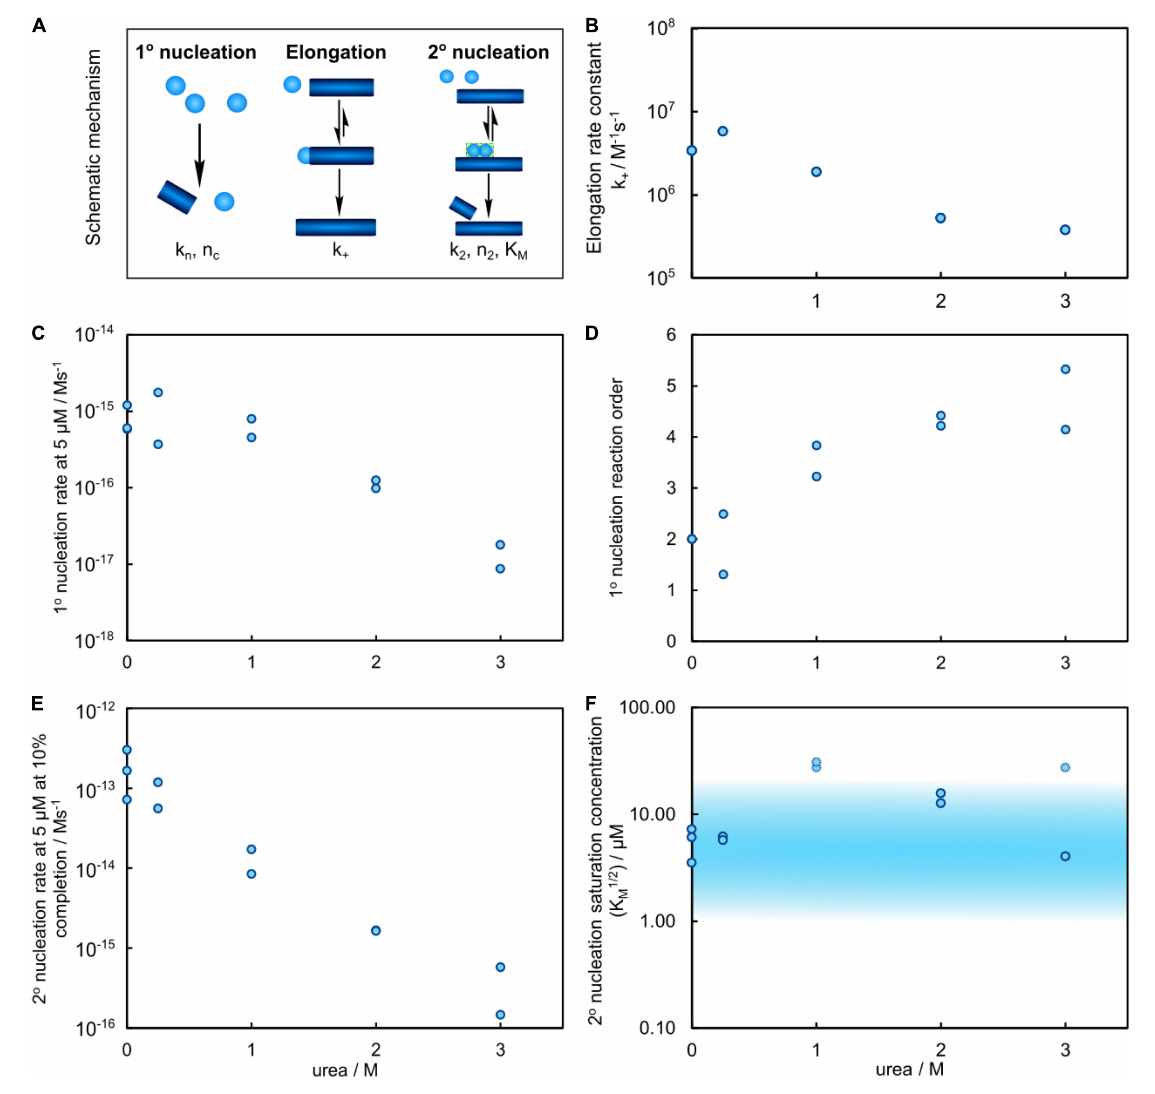
FIGURE6 Results of the global fitting for the aggregation process of A β 42 in urea. (A) Schematic of the individual processes of the aggregation reaction, with their associated parameters. (B) Estimation of the elongation rate constant from the cryo-TEM measurements and heavily seeded aggregation experiments versus urea concentration shows a decrease of the rate by approximately one order of magnitude at 3 M urea. (C) The primary nucleation rate versus urea concentration, evaluated for 5 µ M A β 42, decreases by approximately 2 orders of magnitude in 3 M urea. (D) The reaction order of primary nucleation, related to the associated nucleus size, shows a clear and significant increase with increasing urea concentration. (E) The secondary nucleation rate (for 5 µ M A β 42 at 10% completion), decreases by approximately 3 orders of magnitude. (F) The monomer concentration at which secondary nucleation becomes half saturated versus urea concentration. The shaded region marks values within the region of sampled monomer concentrations which are thus more well constrained. At 1 M urea the reaction is not significantly saturated, so only a lower bound on the saturation concentration can be obtained, as shown by the faint